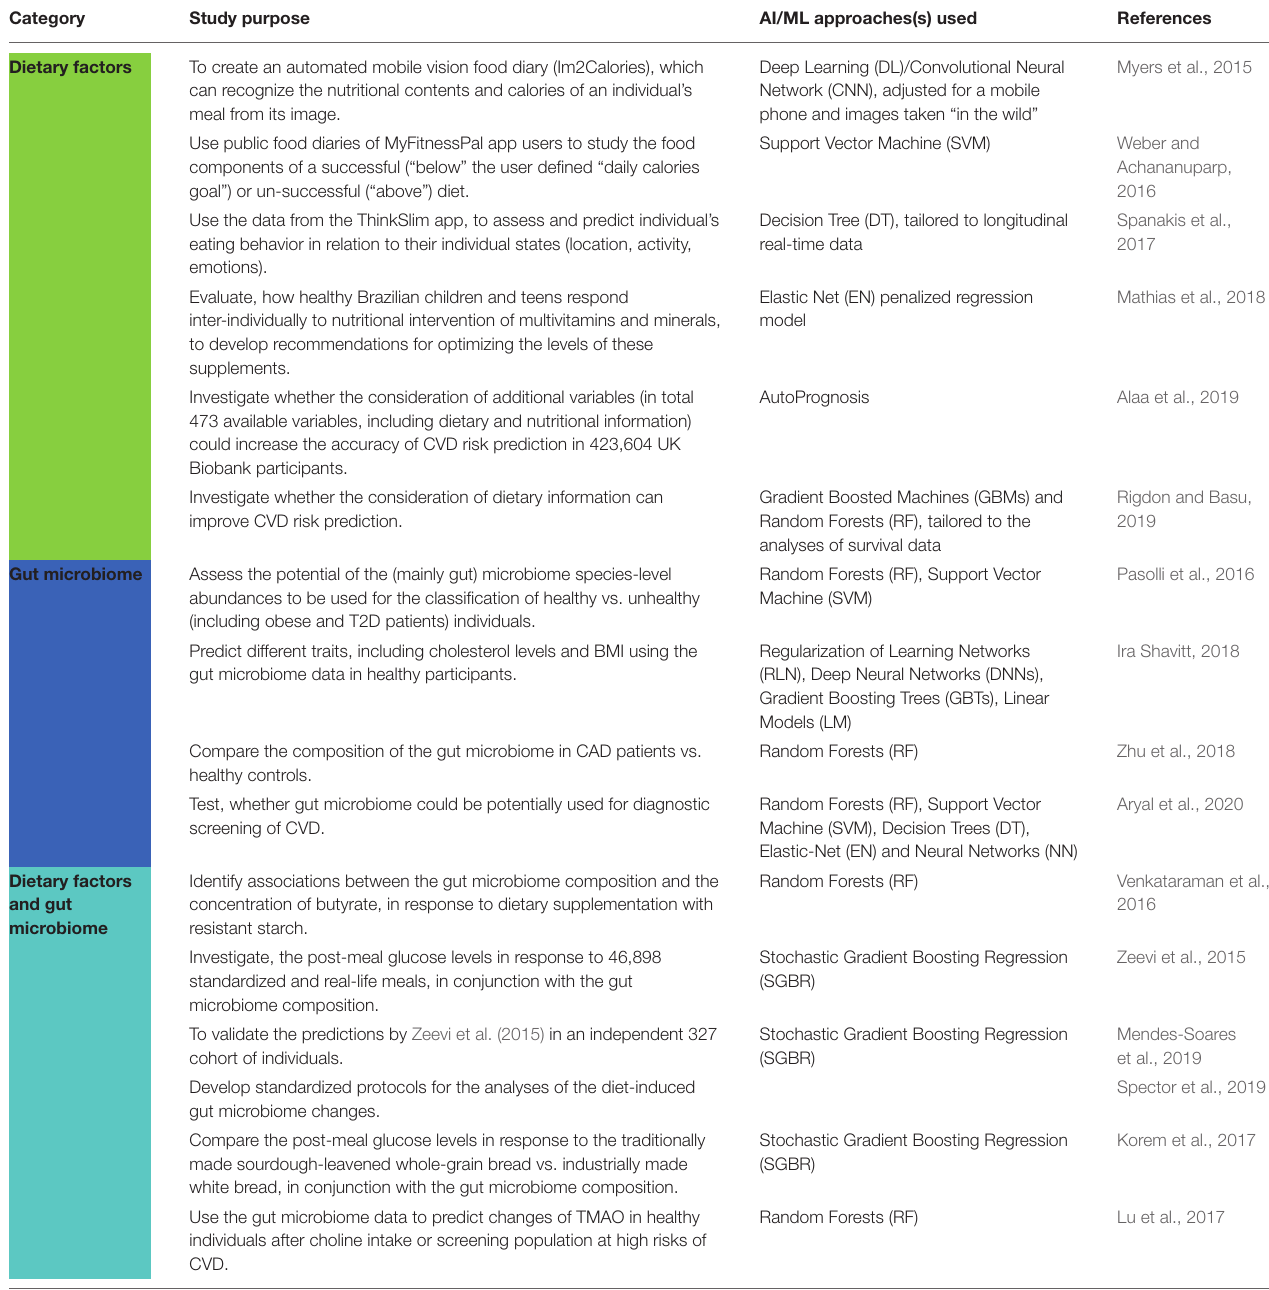
TABLE 1 | A list of the case studies related to improved CAD risk prediction considered in this